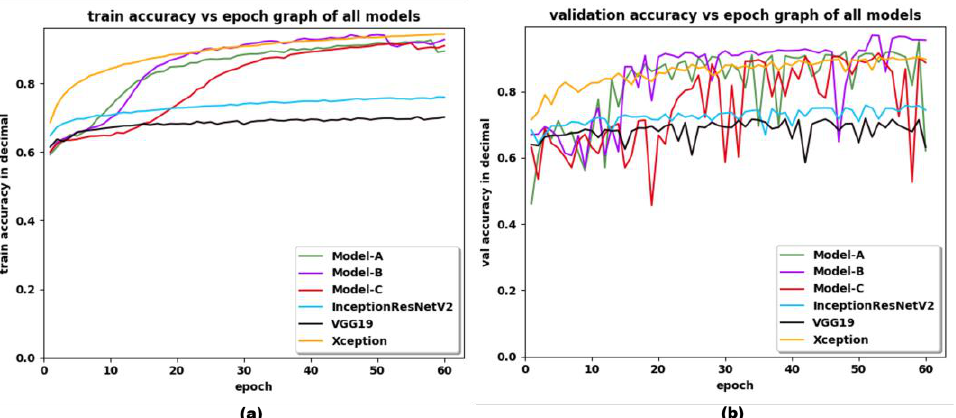
Figure 5. ( a ) Train and ( b ) validation accuracy of Inception-ResNet-v2, Xception, VGG-19, Model-A, Model-B, and Model-C obtained with sample DFDC dataset when trained up to 60 epochs. The input resolution for Model-A, Model-B, and Model-C is 1080 × 1920. Table 4. Accuracy, recall, precision, AUC obtained with train and validation data (DFDC sample).